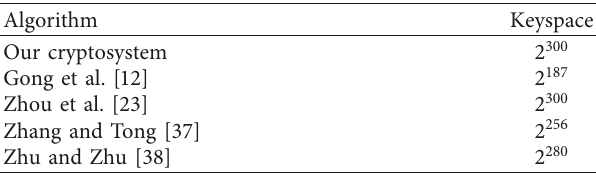
Table 1: Keyspace comparison. Algorithm